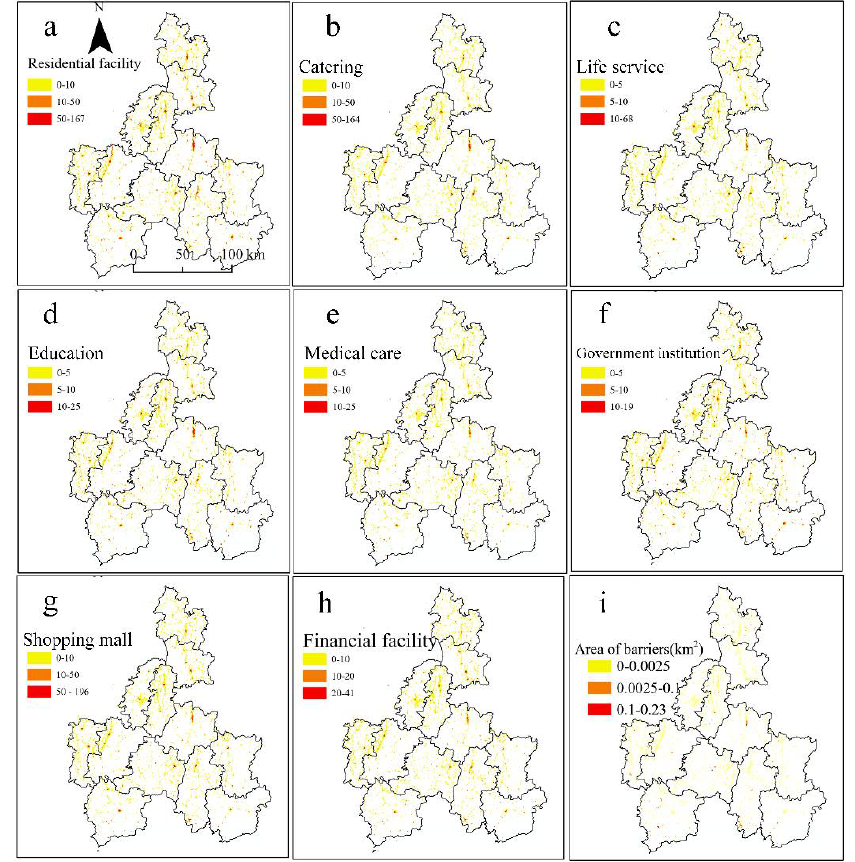
Figure 8. ( a – h ) Distribution of POI data and ( i ) area of geographic barriers in grid scale.